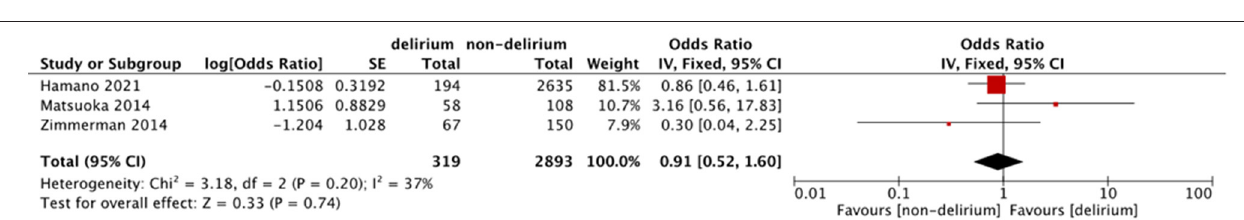
FIGURE 2 | Forest plots of meta-analysis of risk factors for delirium in the palliative care population. (A) Age. (B) Male sex. (C) Hypoxia. (D) Dehydration. (E) Cachexia. (F) Opioid use. (G) Steroid use. (H) Anticholinergic burden. (I) Eastern Cooperative Oncology Group Performance Status. (J) Comorbidity. (K) Tumor of central nervous system.